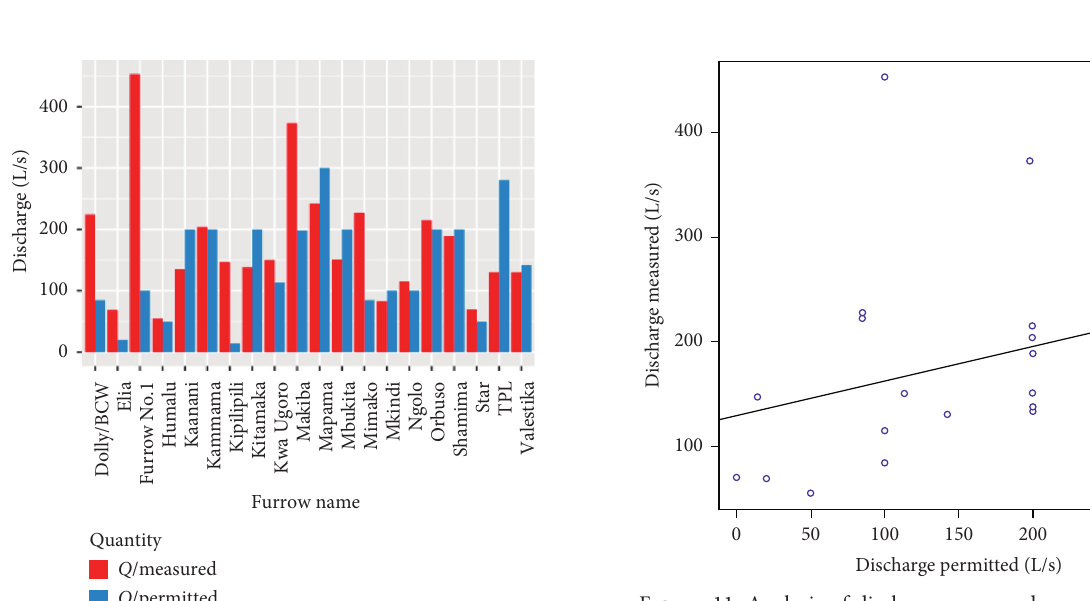
Figure 9: Efficiency-loss against distance.